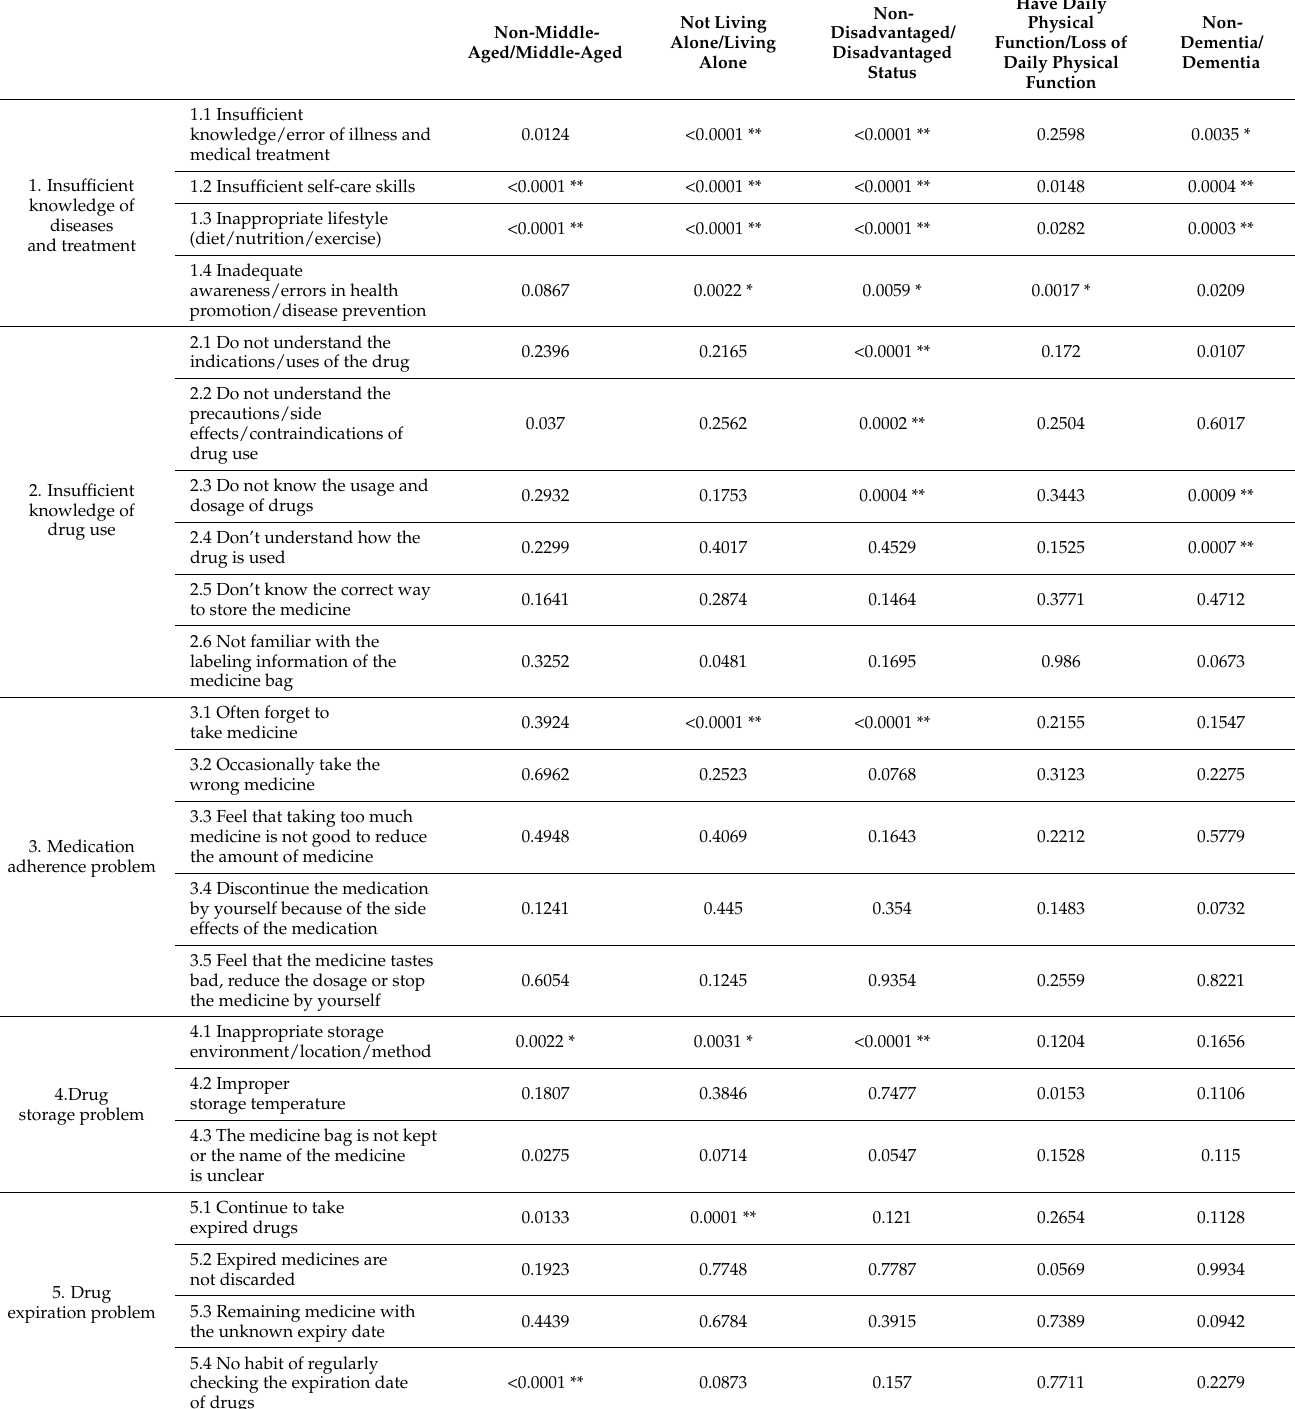
Table 3. Patients’ medication